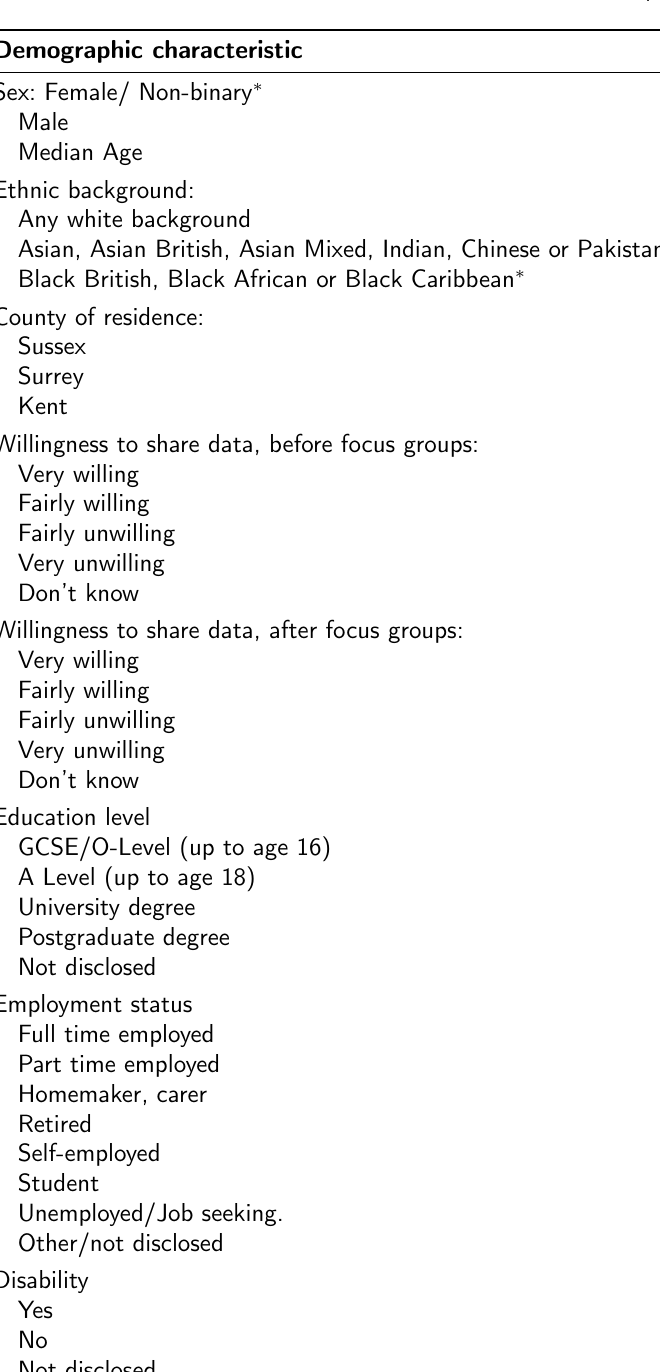
Table 2: Participant